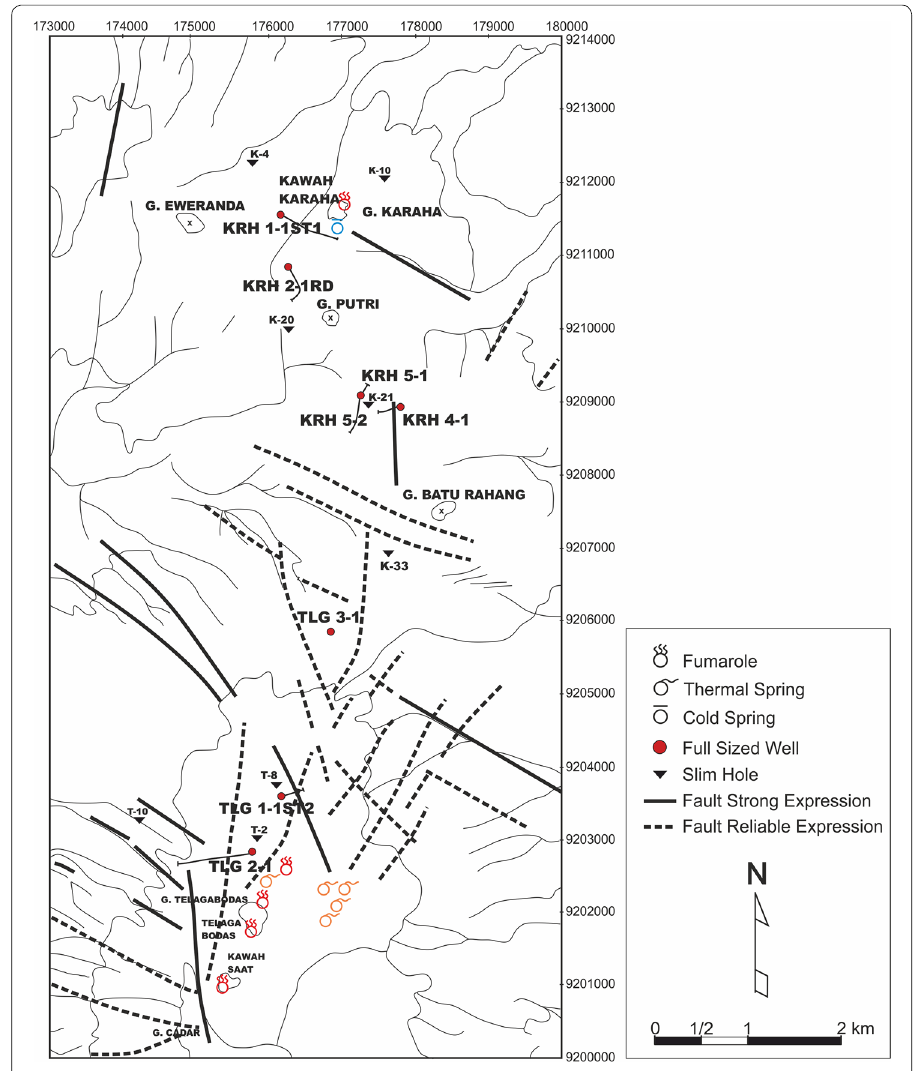
Fig. 3 The fault distribution map in Karaha–Talaga Bodas area (Geothermex